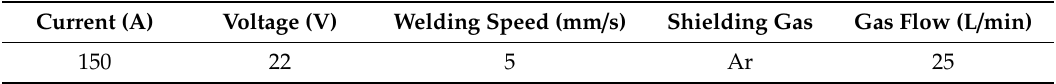
Figure 1. Schematic diagram of the MIG surfacing process. Table 2. MIG surfacing parameters.